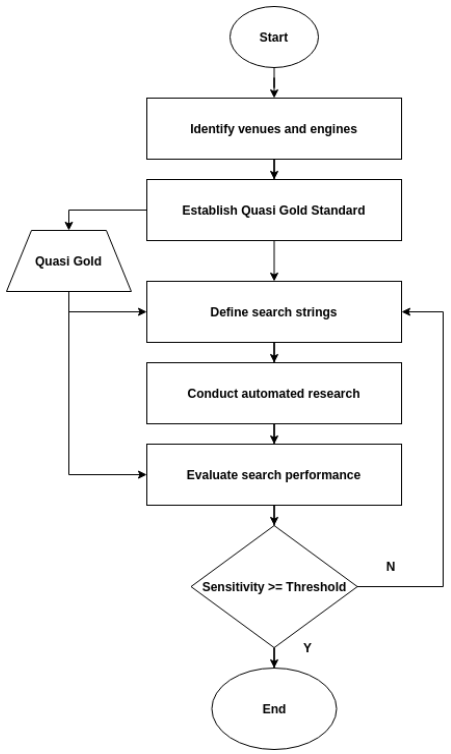
Figure 1. Validation of the research string.